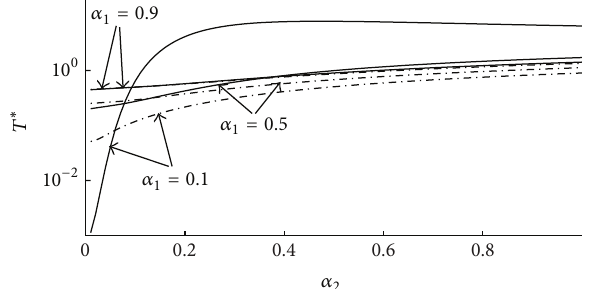
Figure 16: The boundary trajectories for double integrator of fractional order at 𝛼 1 = 𝛼 2 = 0.5 and 𝑙 = 1 .